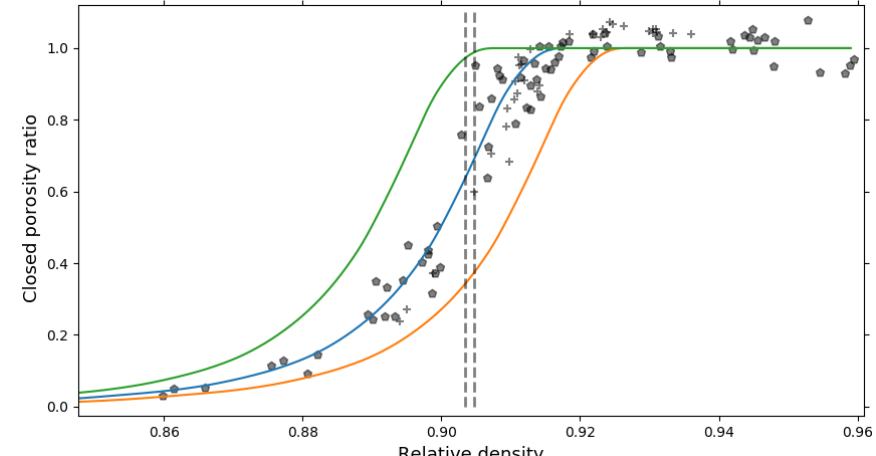
Figure 4. Closed porosity law used in the gas-trapping model. Pentagons and crosses are respectively the pycnometry and tomography data (similar to Figure 2c). The blue curve is a fit to these data. The orange and green curves are the closed porosities needed to reproduce the measured air content respectively in the case of iso-compression and incompressible bubbles. The dotted vertical lines represent the relative densities during closure estimated from the two air content